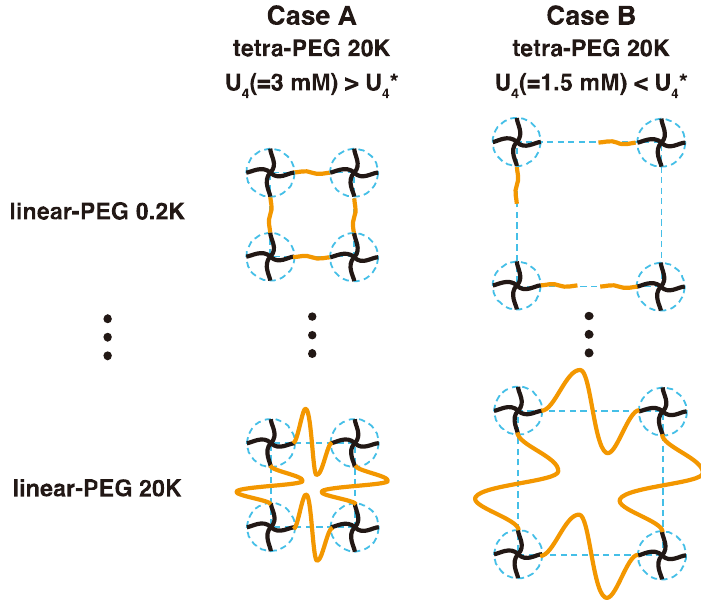
Figure 2. Schematic illustration of 2 × 4 gels formed by mixing mutual reactive tetra-functional PEG and linear-PEG polymers. ( Case A ) Complete network. The molar concentration of tetra-PEG ( U 4 ) in the initial solution is set to be 3.0 mM, higher than its overlapping concentration ( U 4* = 2.1 mM for tetra-PEG with molecular weight 20 k) [17]. Linear-PEG with different molecular weights were used as a spacer chain to connect tetra-PEGs. These 2 × 4 gels have the constant crosslinker density but different molecular weights between the crosslinkers. ( Case B ) Incomplete network. U 4 of tetra-PEG in the initial solution is set to be 1.5 mM, lower than its overlapping concentration ( U 4* = 2.1 mM). Polymer gels with many defects are expected to be formed for short linear-PEGs and complete network to be formed for long linear-PEGs.